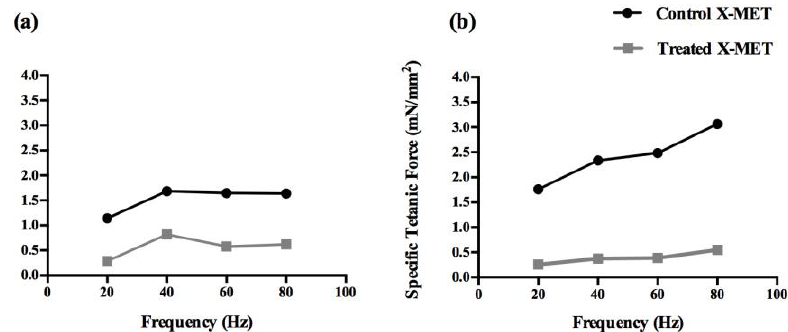
Figure 9. The force – frequency curves for one control and one treated X-MET obtained on day 0 ( a ) and day 4 ( b ) of